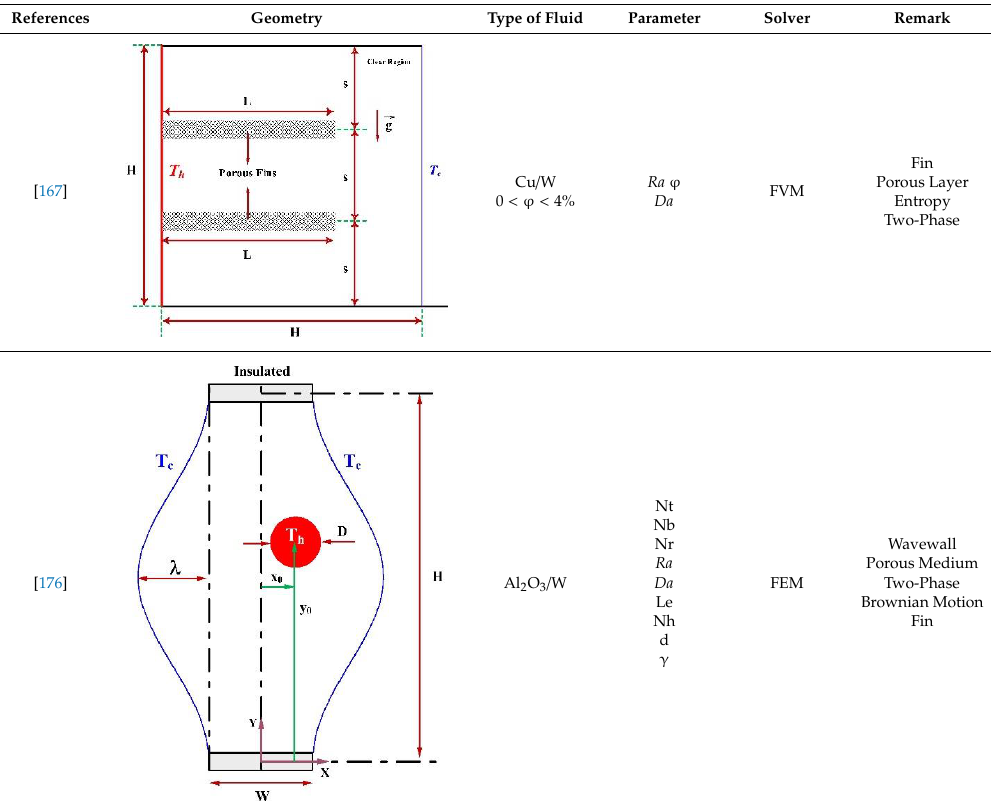
Table 12. Summary of some articles related to two-phase nanofluid flow in enclosures.